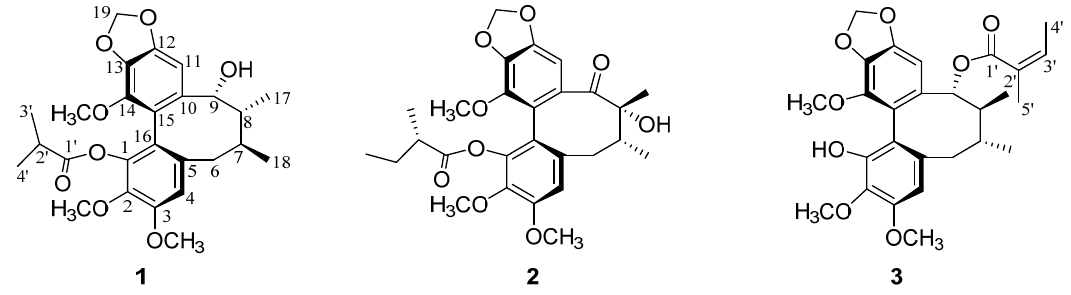
Figure 1. Structures of heilaohulignans A–C ( 1 – 3 ).